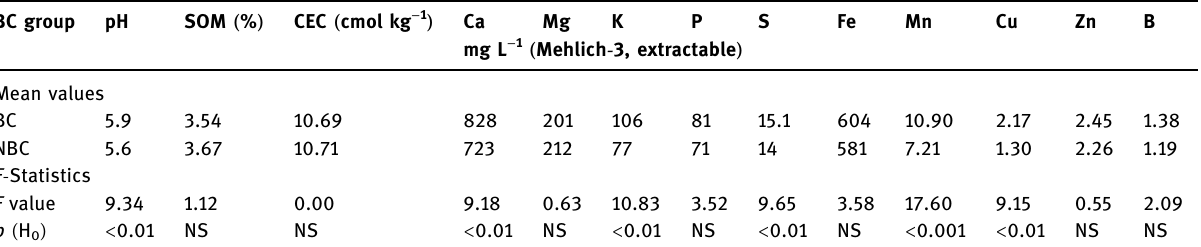
Table 2: E ff ect of biochar amendment on soil parameters in topsoil ( 0 – 15 cm ) . Control ( T1 ) was excluded from the analysis. NBC includes T2 ( NPK ) and T3 ( NPK + micronutrient ) treatments, whereas BC includes all treatments that received biochar. Data for all 3 years were included in the analysis